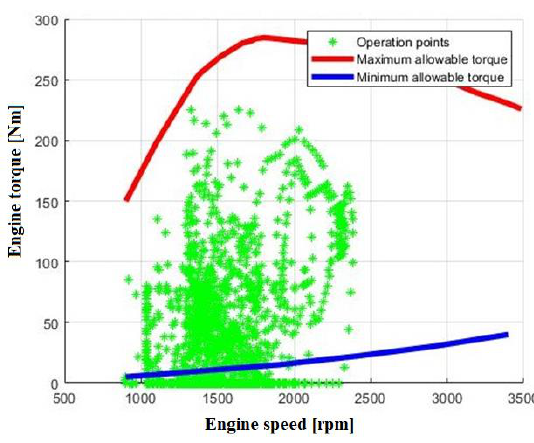
Fig. 7. Calculated engine torque vs. time profile under WLTC 3b In Figure 7 presented covered speed/power region for selected diesel vehicle during WLTC 3b. Moreover, Fig. 7 shows two curves. Red one represents maximum torque curve presented in (Volkswagen, n.d.). Blue one represents minimum available torque that the engine can obtain. Min- imum torque curve is a result of the characteristics of the hydraulic dynamometer (The hydraulic dynamometer al- ways is under load conditions, therefore engine cannot obtain a torque under its minimum).